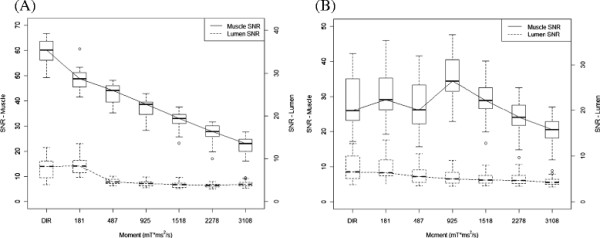
iMSDE first moment optimization for T
1
-w (A) and T
2
-w (B) contrast (6 volunteers, 48 locations).